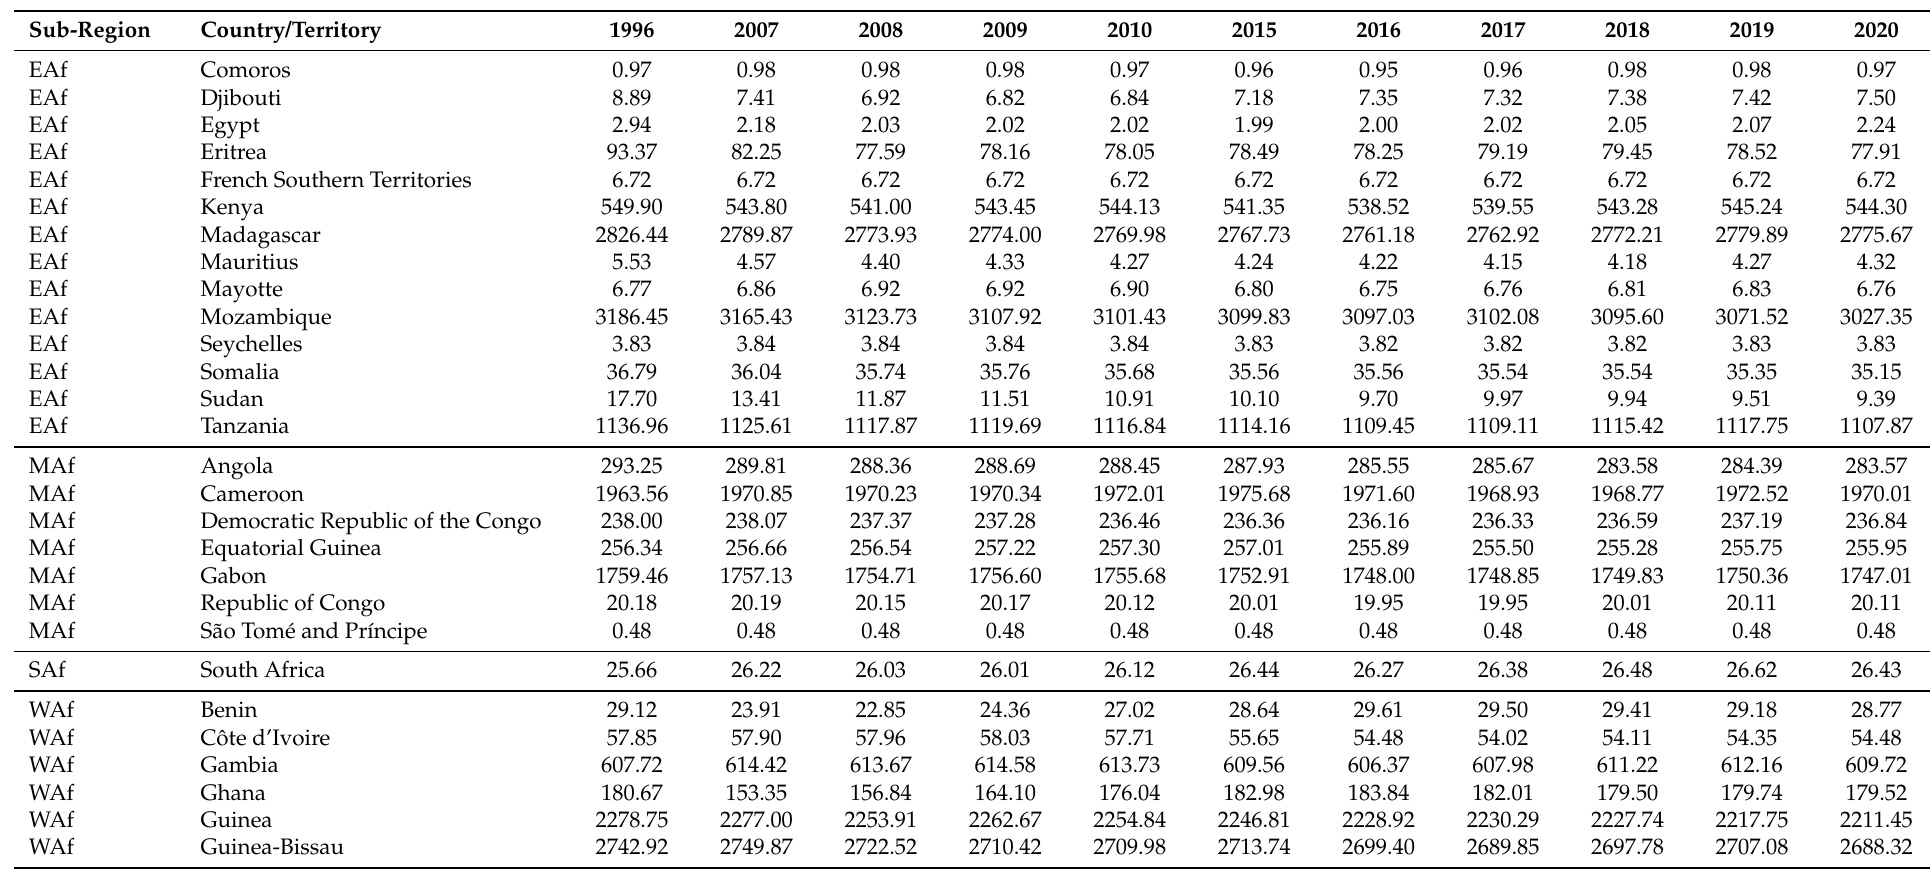
Table A1. Mangrove extent estimates 1996–2020 for the UN Statistics geographic regions in km 2 . Where Sub-region codes are: EAf: East Africa; MAf: Middle Africa; SAf: Southern Africa; WAf: Western Africa; Car: Caribbean; CAm: Central America; SAm: South America; NAm: Northern America; EAs: Eastern Asia; SEAs: Southeastern Asia; SAs: Southern Asia; WAs: Western Asia; ANZ: Australia & New Zealand; Mel: Melanesia; Mic: Micronesia; Pol: Polynesia. Note: reported mangrove extent estimates account for known map commission and omission